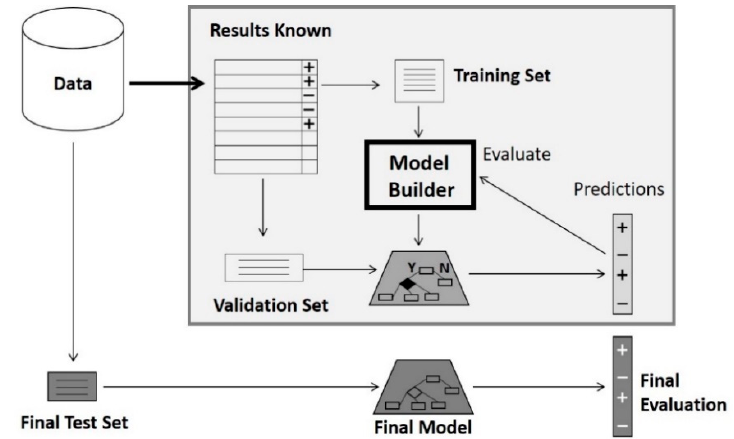
// blog.algorithmia.com / page / 50